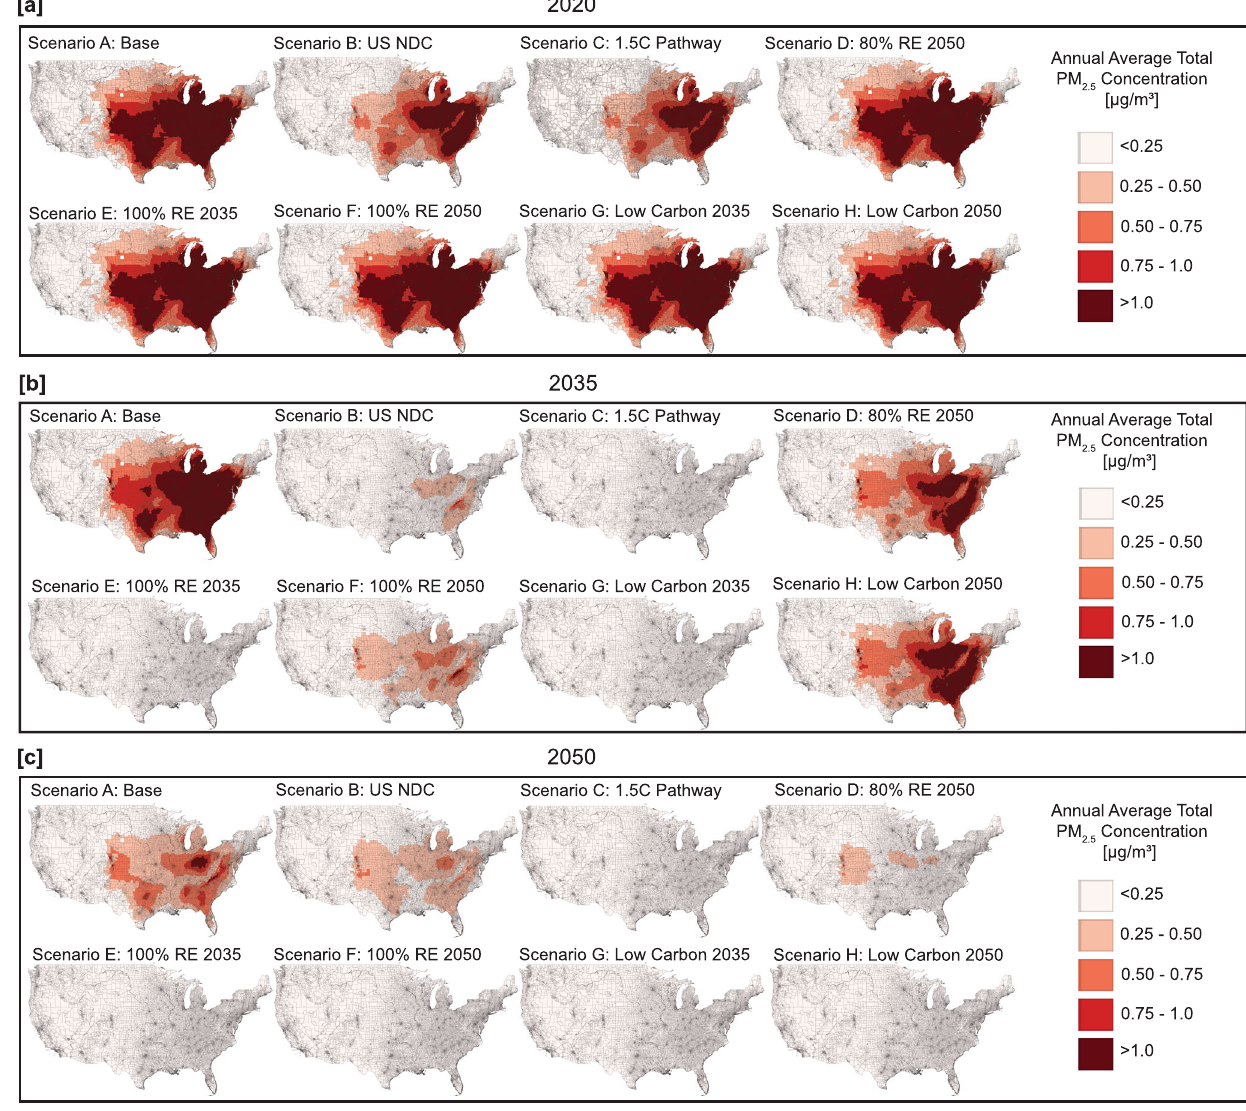
Fig. 3 | Regional distribution of PM 2.5 across decarbonization scenarios for 2020, 2035, and 2050. Total PM2.5 air pollution from power plants across sce- narios: a 2020, b 2035,and c 2050.By2035,theonlyscenarioswith100%ofregions below the threshold of 0.25 µ g/m 3 include the aggressive carbon cap (Scenario